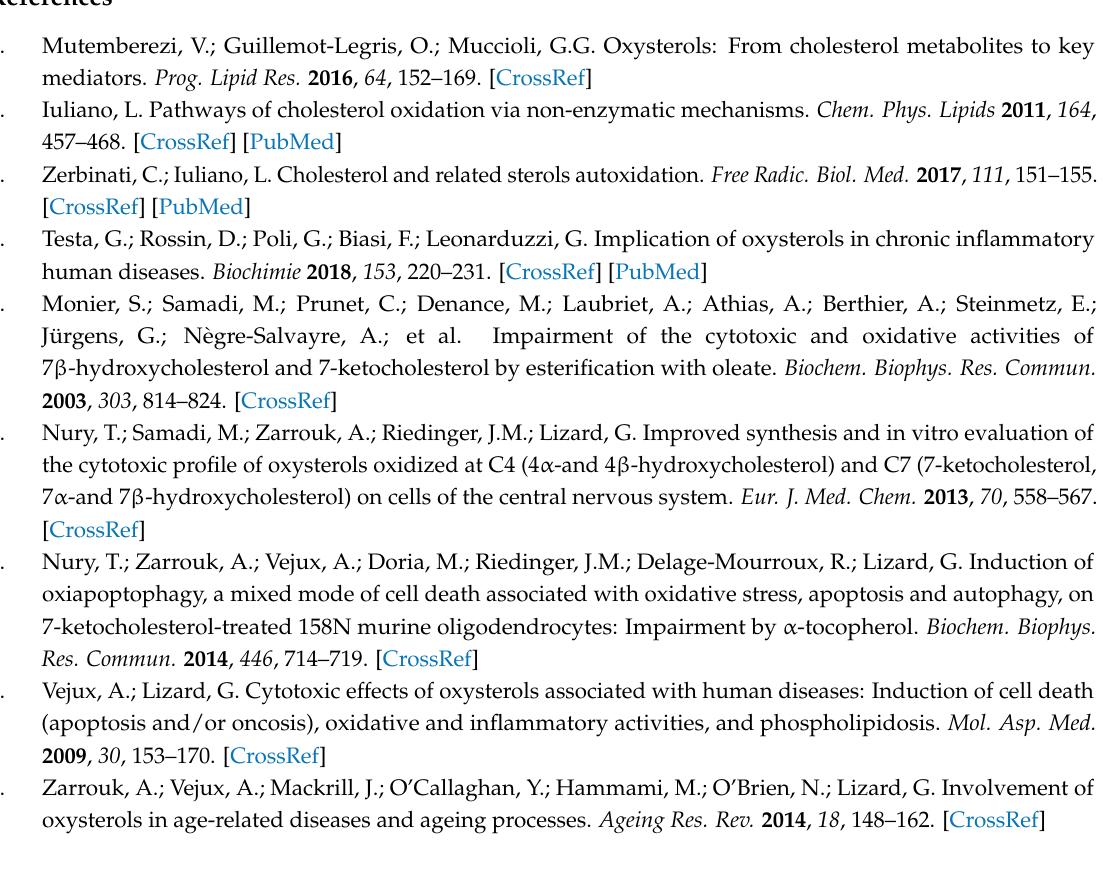
Figure S1: 7-ketocholesterol (7KC) structure, Table S1: Effect of mint extracts on cytokine